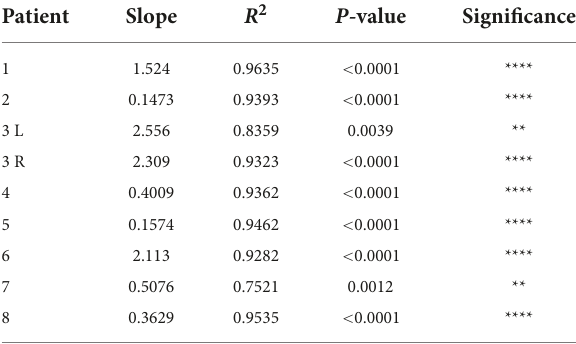
TABLE 3 Linear regression analysis of the evolution of range of motion of shoulder elevation angle over